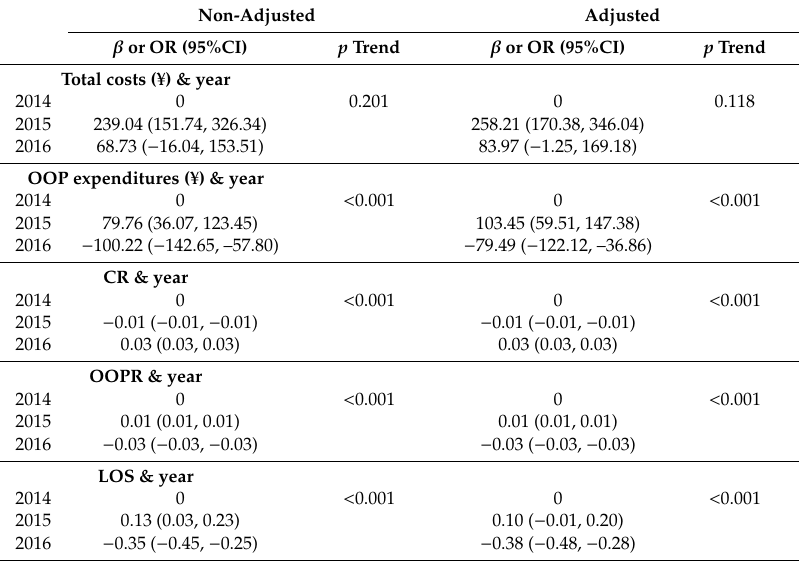
Table 2. Results of multivariable linear / logistic regression models for the whole